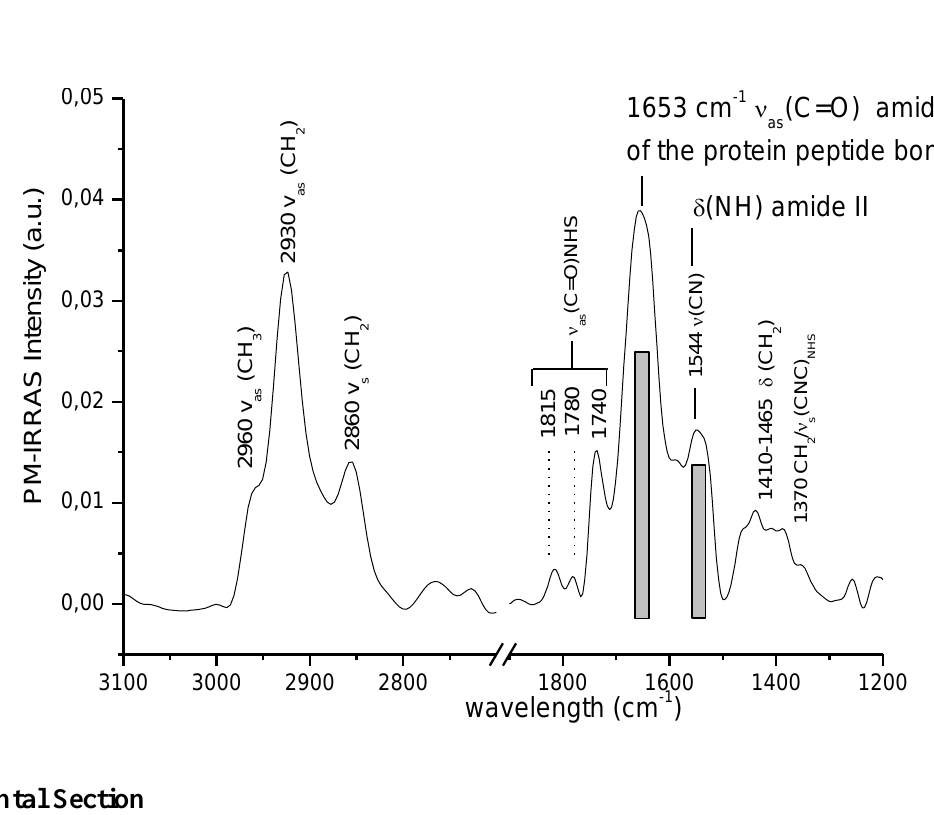
Figure 7. PM-IRRAS analysis of the planar waveguides functionalized after reaction with MUA, NHS/EDC and